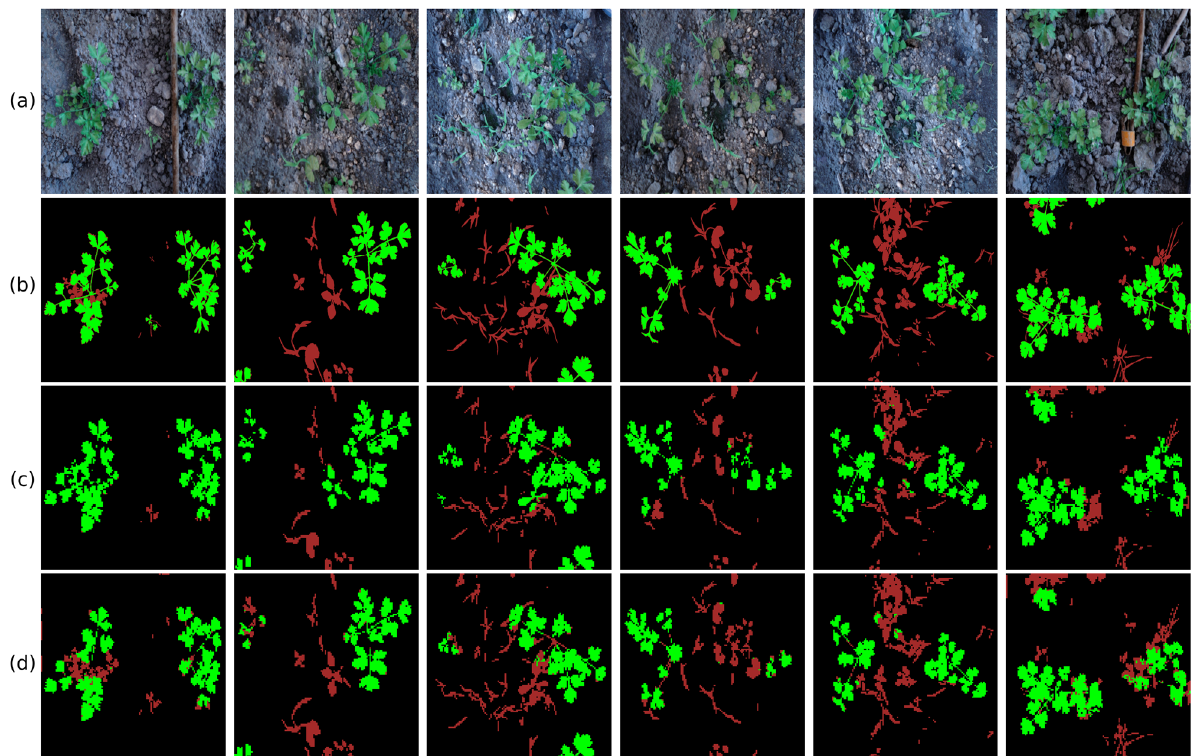
Figure 7 . Segmentation results of models. (a) Samples of original images. (b) Ground truth. (c) Segmentation results of U-Net. (d) Segmentation results of